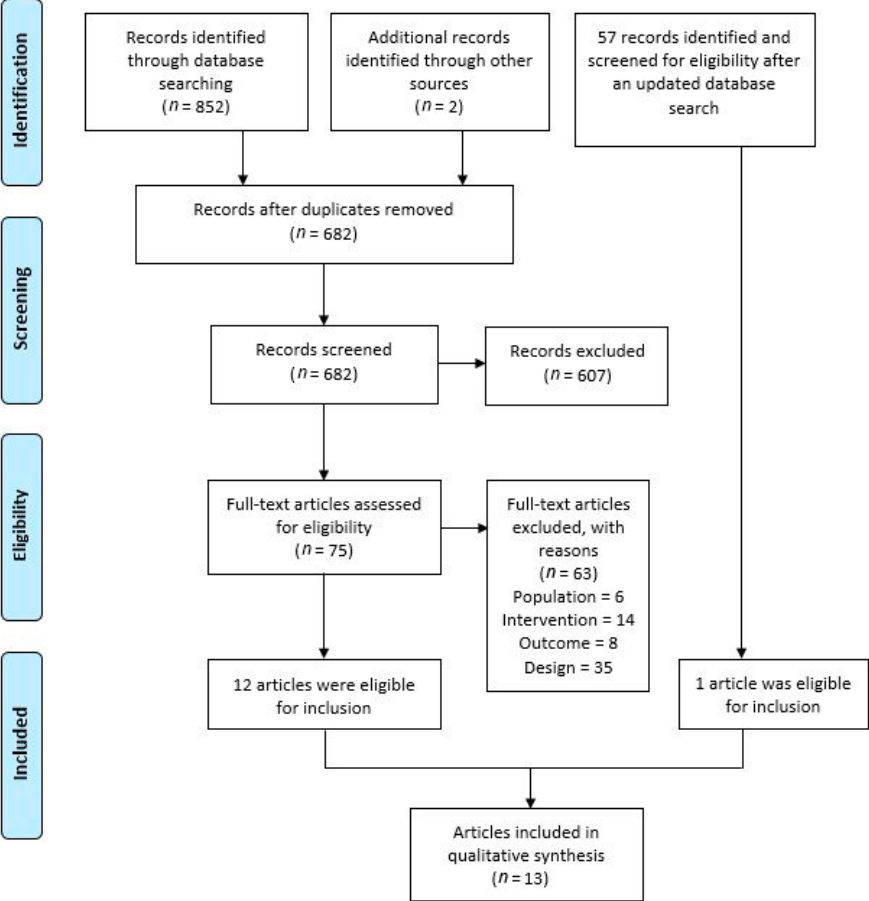
Figure 1. PRISMA flowchart of articles selection (adapted from Moher et al. [18]).